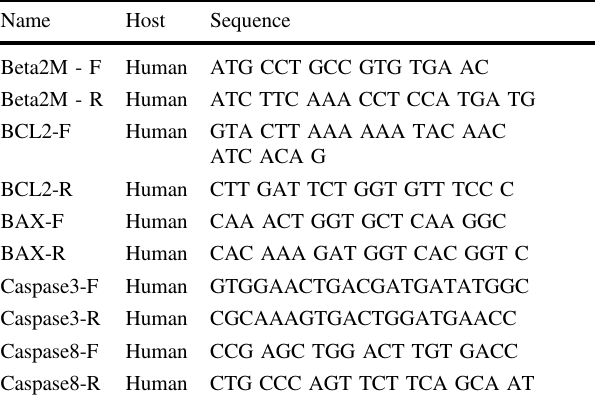
Table 1 The primer sequences of the studied genes related to the apoptosis